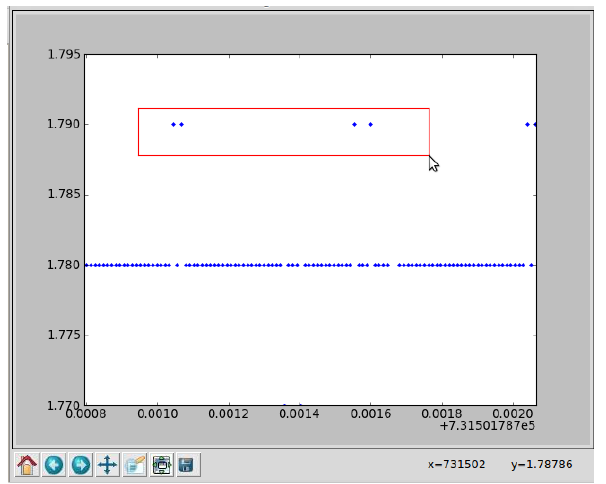
Figure 2. This is an example of an interactive method. In this case, the method asks the user to choose a data type to display. The user can then choose to use an automatic outliers removal tool or to zoom in and select the points that need to be masked with a few clicks of the mouse. Here, the points in the red rectangle will be masked when the user confirms